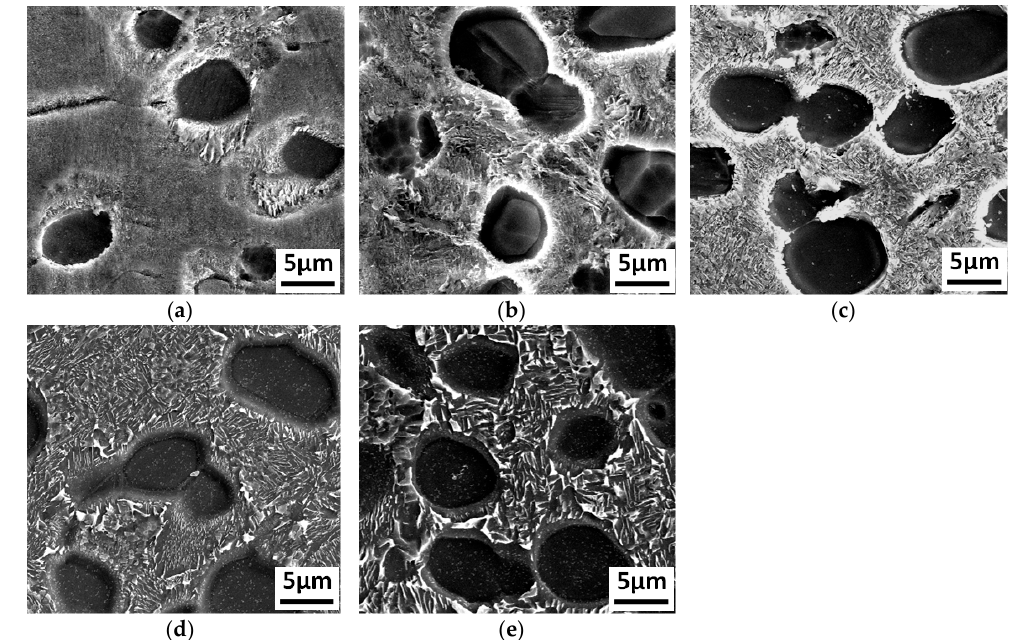
Figure 9. The Ti 3 Al LFW joint microstructures in the BM zone after heat treatments at different temperatures: ( a ) after heat treatment at 700 °C, ( b ) after heat treatment at 750 °C, ( c ) after heat temperatures: ( a ) after heat treatment at 700 ◦ C, ( b ) after heat treatment at 750 ◦ C, ( c ) after heat treatment at 800 °C, ( d ) after heat treatment at 850 °C, and ( e ) after heat treatment at 900 °C. treatment at 800 ◦ C, ( d ) after heat treatment at 850 ◦ C, and ( e ) after heat treatment at 900 ◦